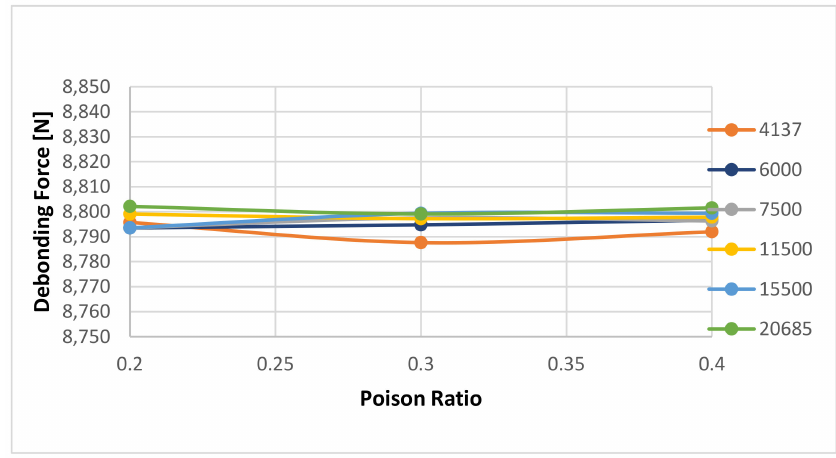
Figure 16. Detailed view of the calculated debonding force as a function of Poisson Ratio and selected Young’s Modulus of the cement with a 1-day curing time.